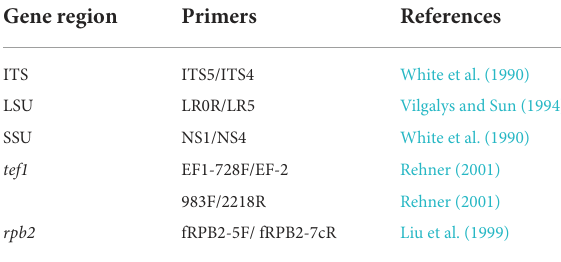
TABLE 1 Genes/loci and PCR primers used in this